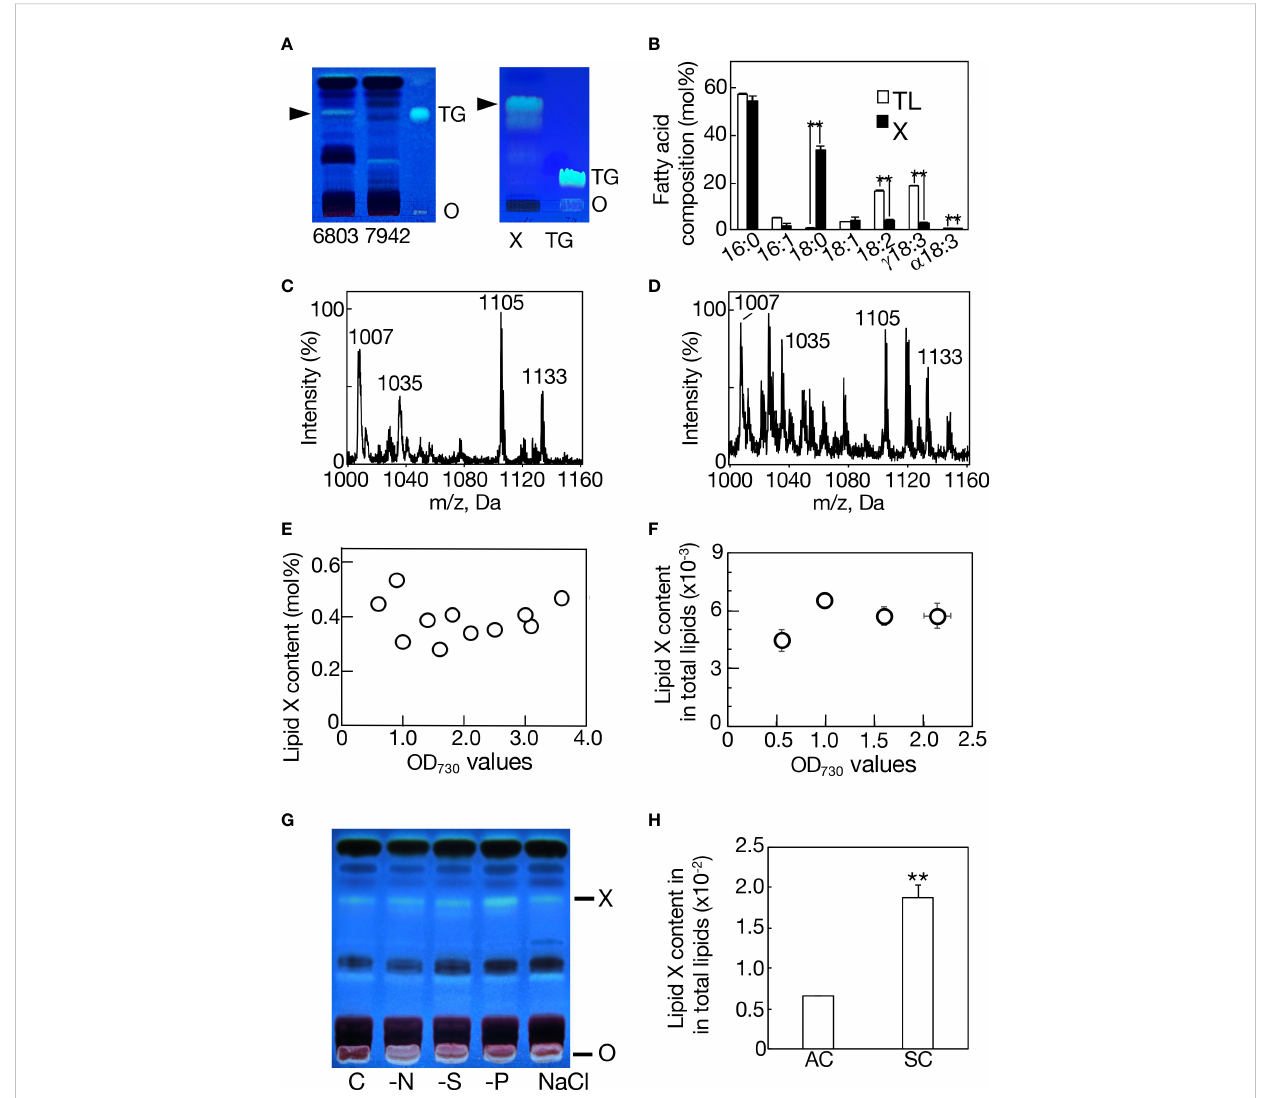
FIGURE 1 Characterization of lipid X in Synechocystis . (A) TLC pro fi les of total lipids in Synechocystis (6803) and Synechococcus (7942) with a solvent system of hexane/diethyl ether/acetate (70:30:1 by vol.) (left panel), and that of lipid X prepared from Synechocystis by TLC, as in the left panel, with another solvent system of 100% toluene (right panel). Arrowheads indicate the position of lipid X. O, origin. TG indicates a marker TG. (B) Fatty acid compositions of total lipids (TL) and lipid X (X). MS spectrum of TLC-prepared lipid X (C) or that of a lipid fraction (retention time of 15-17 min, m/z 1000-1160), including lipid X, in total lipids (D) on LC-MS analysis in Synechocystis . (E) Quantitative behavior of lipid X based on constituent fatty acid contents of TLC-prepared lipid X in total lipids on GC-analysis. (F) Quantitative behavior of a lipid fraction (retention time of 15-17 min, m/z